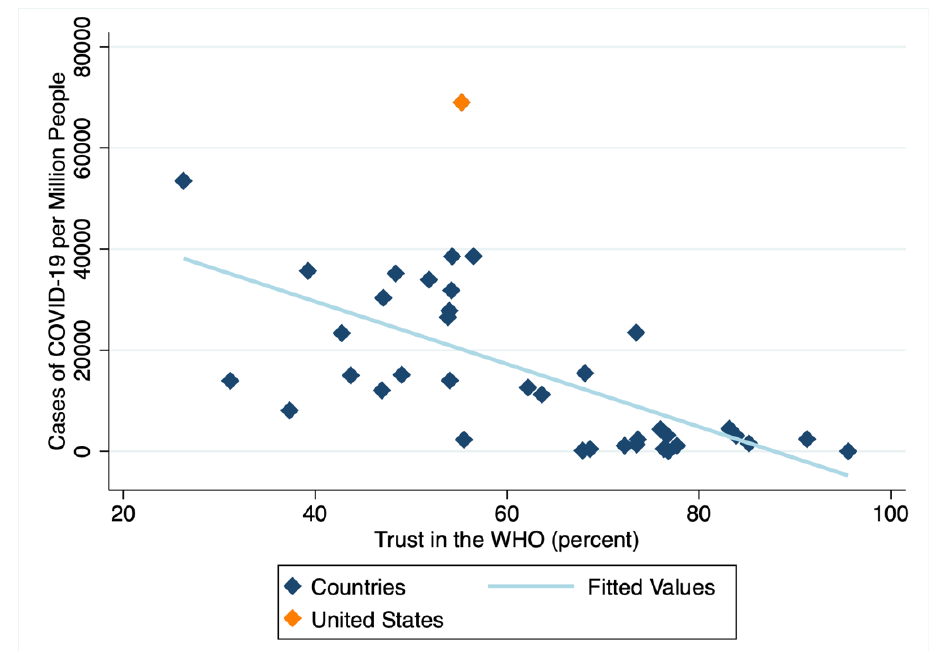
Figure 1: Trust in the WHO and Case of Coronavirus (Feb/2020 -